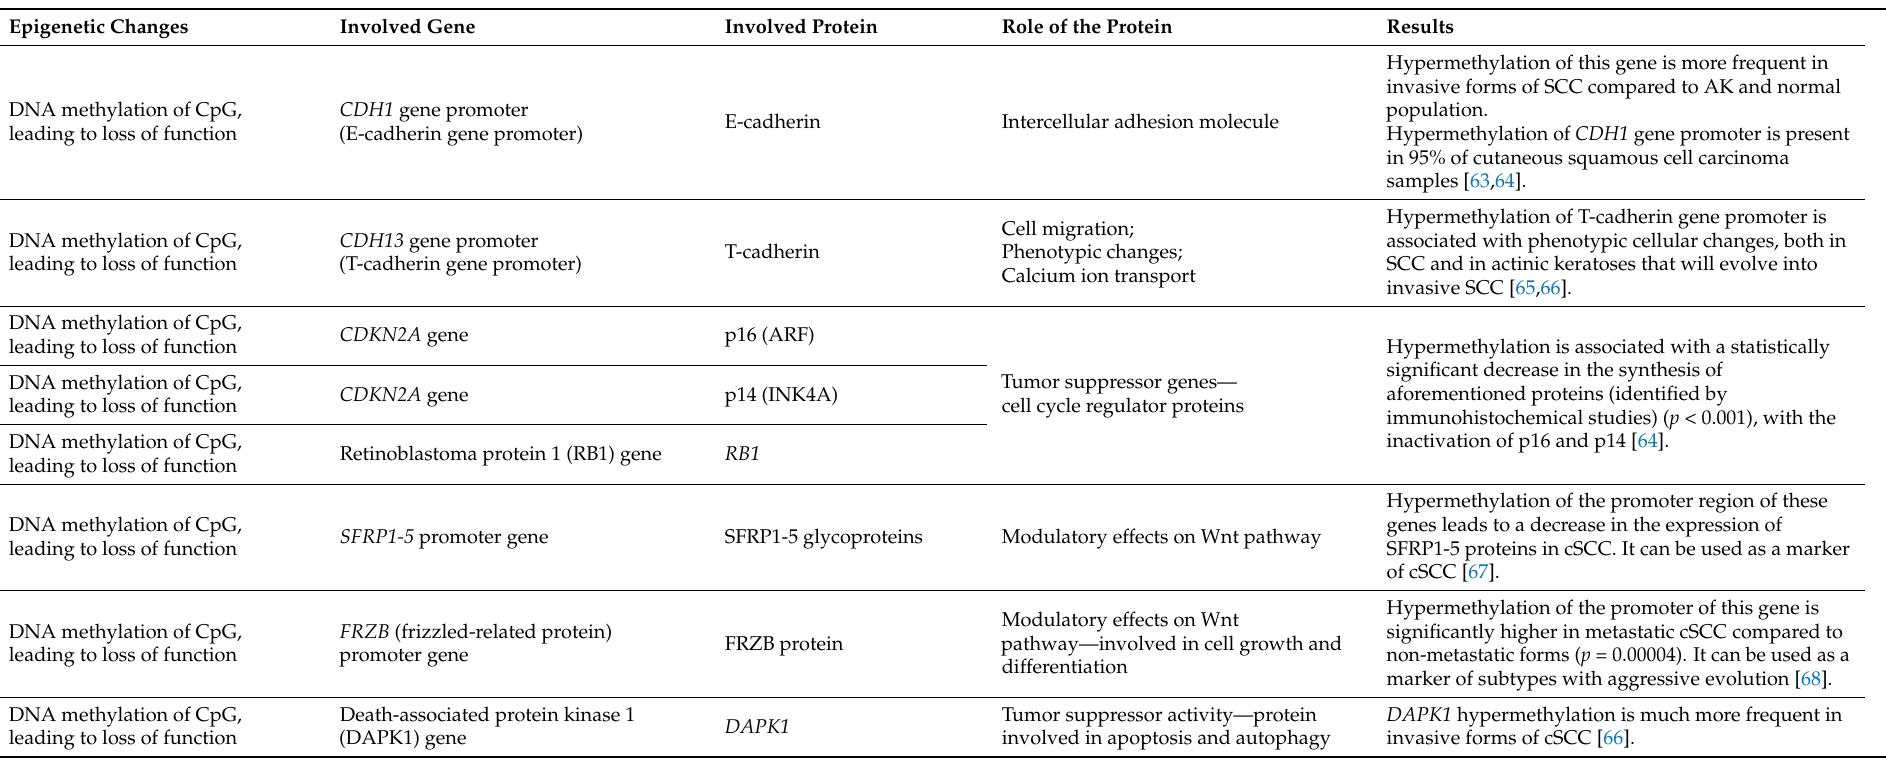
Table 2. DNA methylation changes associated with